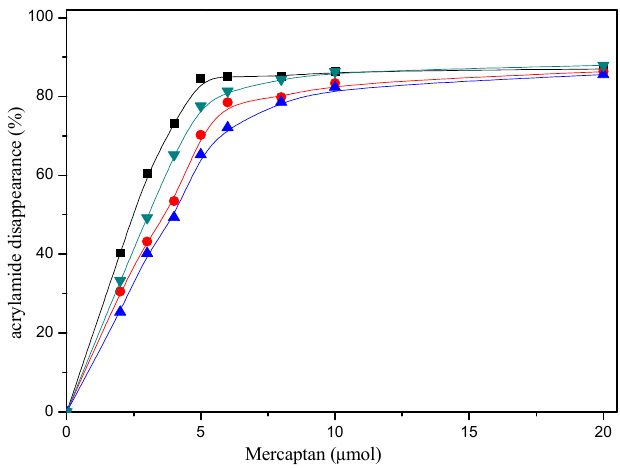
Figure 1. Dose-response effect of selected mercaptans on the acrylamide disappearance after heating an acrylamide (0.2 μ mol)/mercaptans (0–20 μ mol) model system at 180 °C and pH 7 for 30 min. Mercaptans assayed were 1,2-ethanedithiol ( ■ ), 1-butanethiol ( ● ), 2-furanmethanethiol ( ▲ ), and 2- methyl-3-furanthiol ( ▼ ).